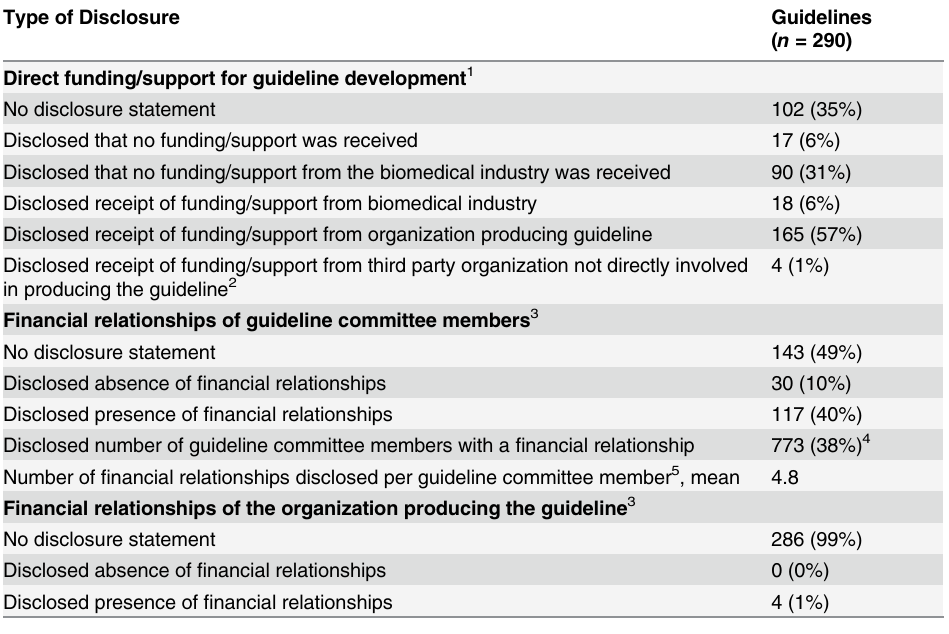
Table 4. Disclosure statements contained within clinical practice